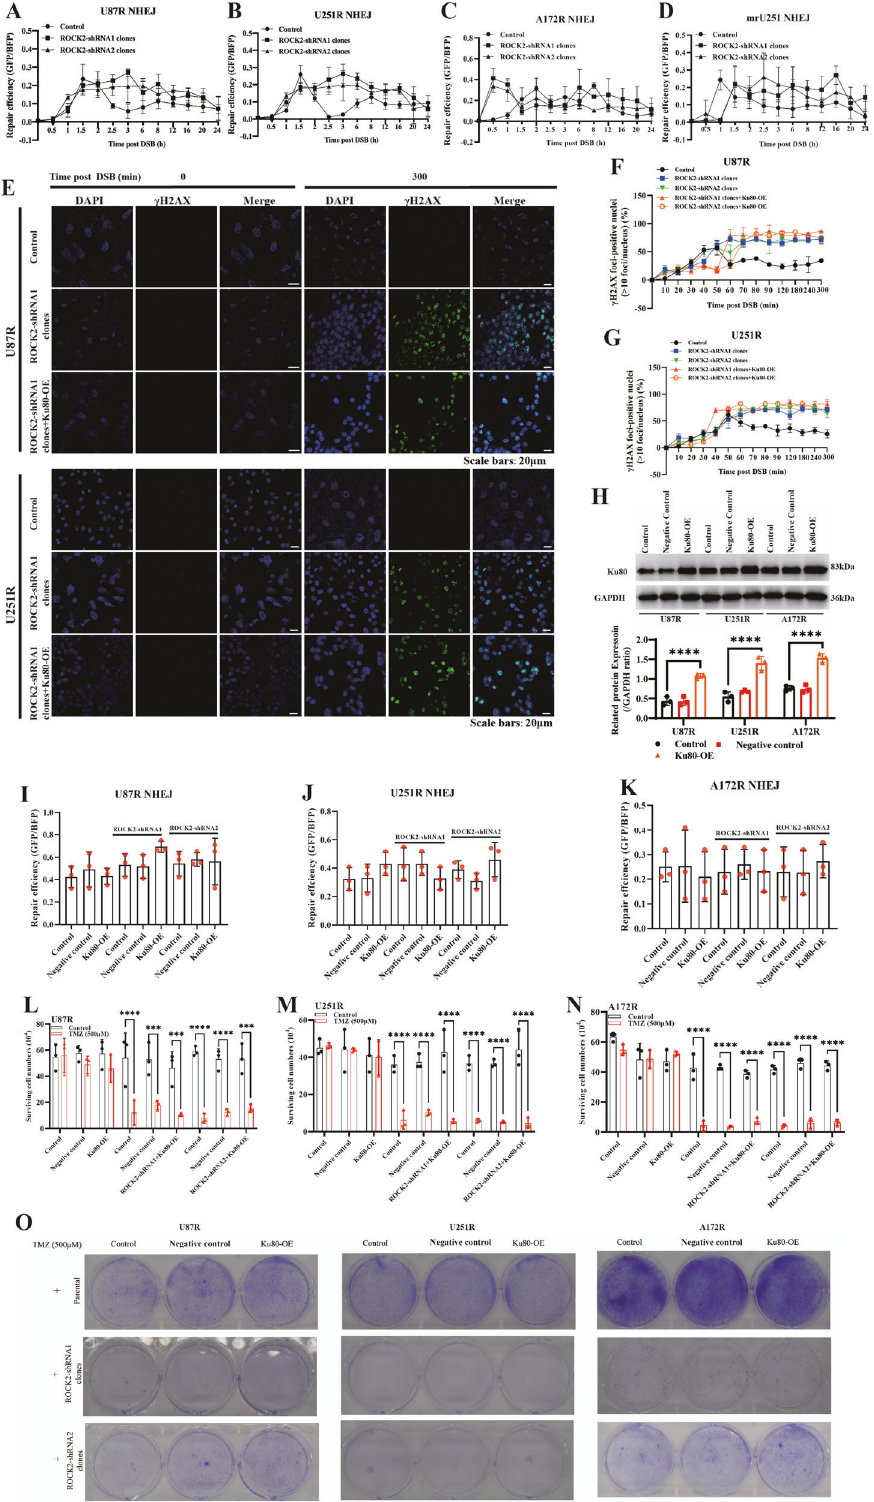
Fig. 4 Enhancement of NHEJ by ROCK2 inhibition was useless for DNA repair in TMZ-R cells. A – D NHEJ versus time was determined in ROCK2-KD cells. E – G γ H2AX foci-positive cells were detected by IF and counted, Scale bars, 20 μ m. H Ku80 expression was determined with Ku80-overexpression plasmids. I – K NHEJ for 24 h was determined in ROCK2-KD cells with Ku80-OE. L – N Cells were counted with TMZ and Ku80-OE in ROCK2-KD cells. O Cells were stained with TMZ and Ku80-OE. Data are shown as mean ± SD of three independent experiments. p values determined by ANOVA t -test. Statistical differences compared with the controls are given as * p < 0.05, ** p < 0.01, *** p < 0.005, **** p < 0.001. Cell Death and Disease (2022)